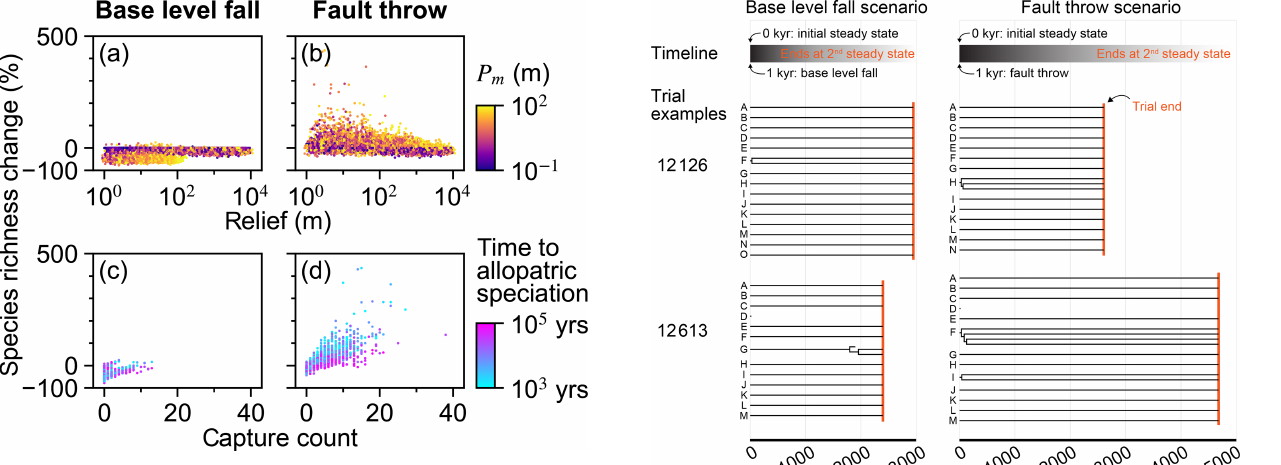
Figure 11. Species richness percent change. Species richness change versus relief (a, b) and capture count (c, d) .